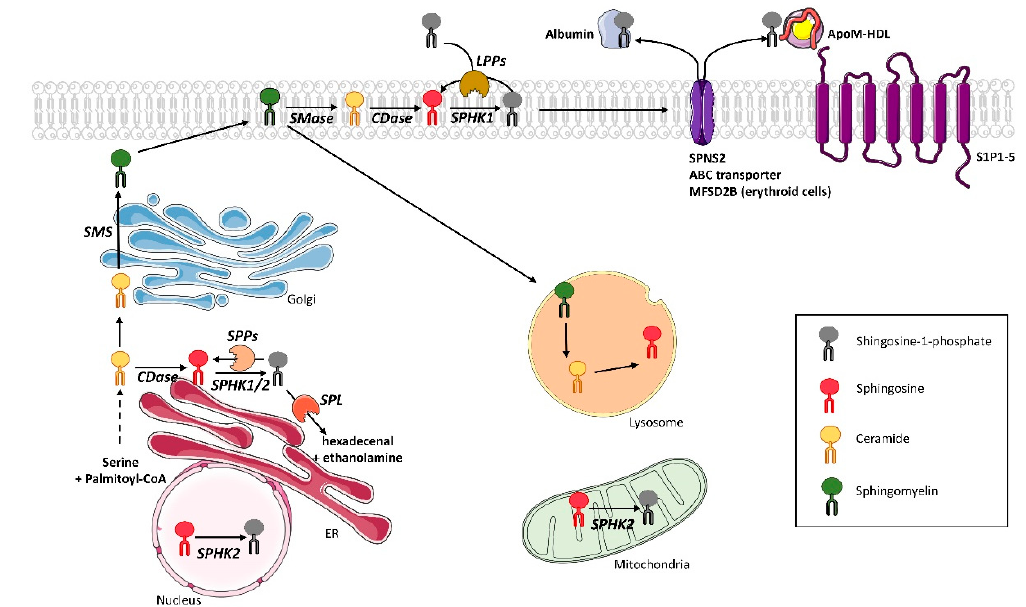
Figure 1. Sphingosine-1-phosphate metabolism in mammals. Sphingolipid de novo synthesis is initiated in the endoplasmic reticulum (ER), starting by the condensation of serine and palmitoyl-coA followed by a cascade of enzymatic reactions to produce ceramide. In the ER, ceramide is deacylated by neutral CDase into sphingosine. Sphingosine is phosphorylated to produce S1P by SphK1 / 2. Produced S1P can be either dephosphorylated back to sphingosine by ER resident SPPs, or irreversibly transformed into hexadecenal and phosphoethanolamine by S1P lyase. Ceramide is transported to the Golgi apparatus to be transformed into SM, which will reach the plasma membrane. In the plasma membrane, SM can be transformed into ceramide through the action of SMases. Ceramide will then be deacylated by acidic CDase to give sphingosine that will be phosphorylated into S1P by SphK1. Produced S1P can be dephosphorylated by ecto-LPPs. S1P can also be secreted through ABC, SPNS2, and MFSD2B transporters in extracellular space to activate S1P receptors. Extracellular S1P can also be transported by either albumin or ApoM / HDL. The latter can activate S1P receptors. SM can be endocytosed to be recycled into ceramide and sphingosine inside lysosomes. SphK2 can catalyze S1P production in the mitochondria and the nucleus. ABC: ATP-binding cassette. CDase: ceramidase. ER: endoplasmic reticulum. HDL: high density lipoproteins. MFSD2B: Major Facilitator Superfamily Domain Containing 2B. S1P: sphingosine-1-phosphate. SM: sphingomyelin. SMase: sphingomyelinase. SphK: sphingosine kinase. S1P1-5: S1P receptor 1 to 5. SPNS2: Spinster homolog